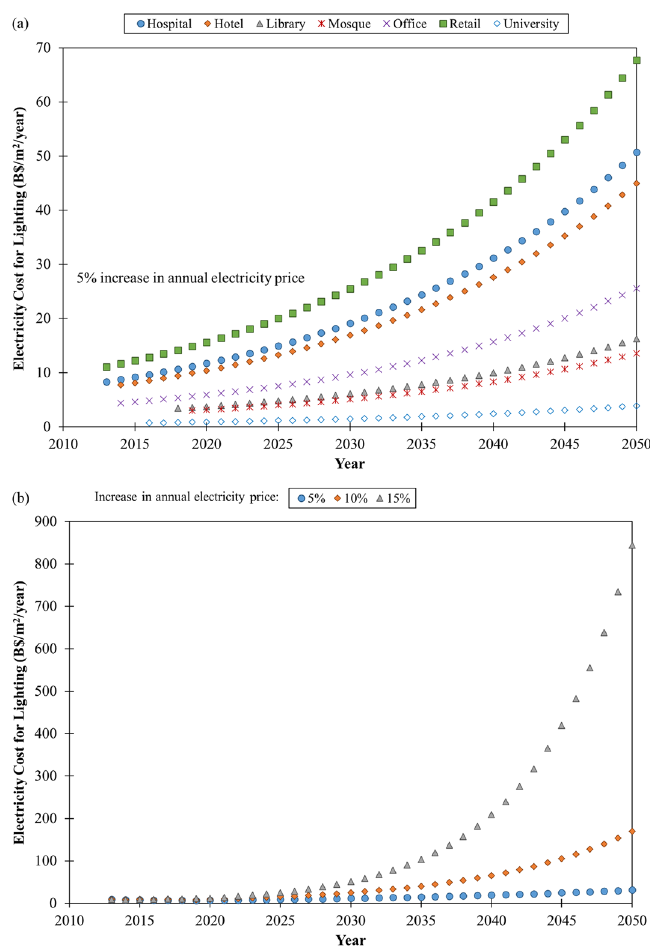
Figure 5. Projection of electrical costs of lighting for (a) different types of commercial buildings in Southeast Asia with a 5% increase in annual electricity price and (b) commercial buildings in the same region with 5%, 10% and 15% increase in annual electricity